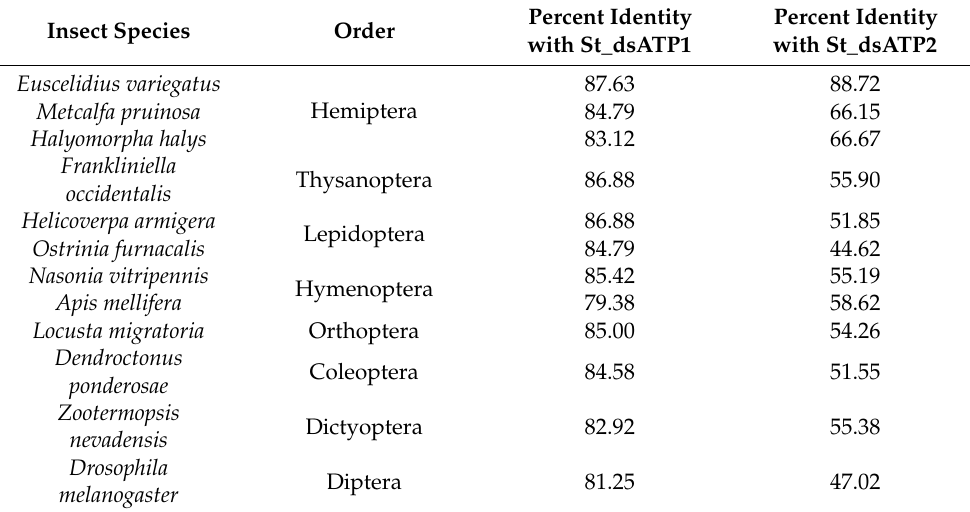
Table 2. Percent identities of sequences encoding ATP synthase β of different insect species aligned with St_dsATP1 and St_dsATP2 targeting ATP synthase β of Scaphoideus titanus . Insect Species